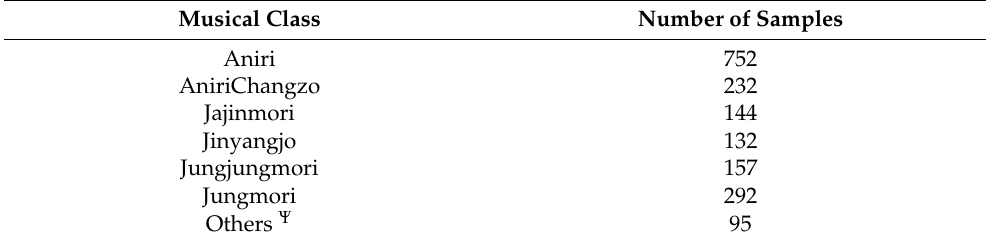
Table 1. Pansori rhythm classification dataset. There is only one rhythm category per